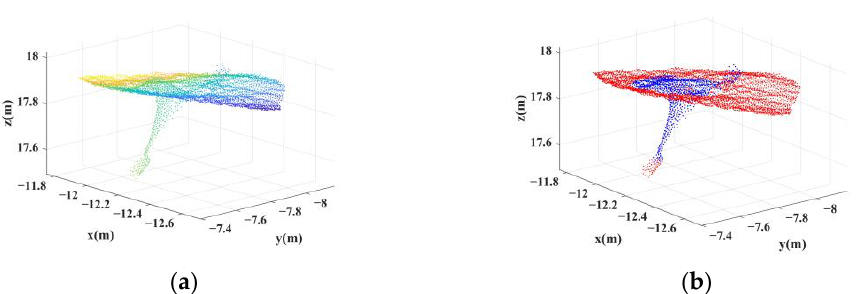
Figure 6. A neighborhood containing anchor rod points. ( a ) Initial point cloud after downsampling. ( b ) Preliminary identification results; points colored in blue are suspected anchor rod points.